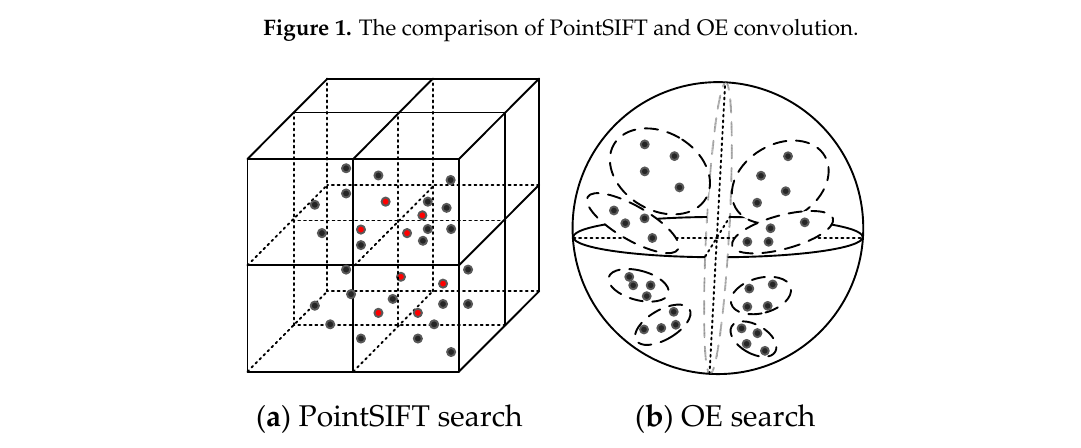
Figure 2. PointSIFT and OE search point methods.